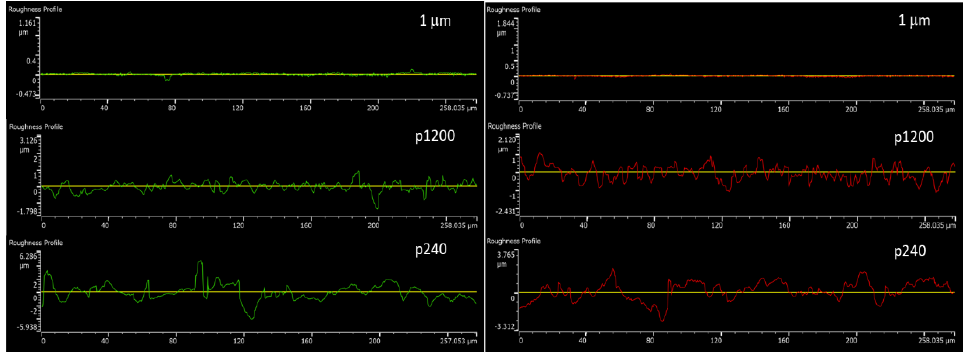
Figure 15. Surface roughness of AA1050 ( right ) and AA6061 ( left ) samples after polishing to different levels.